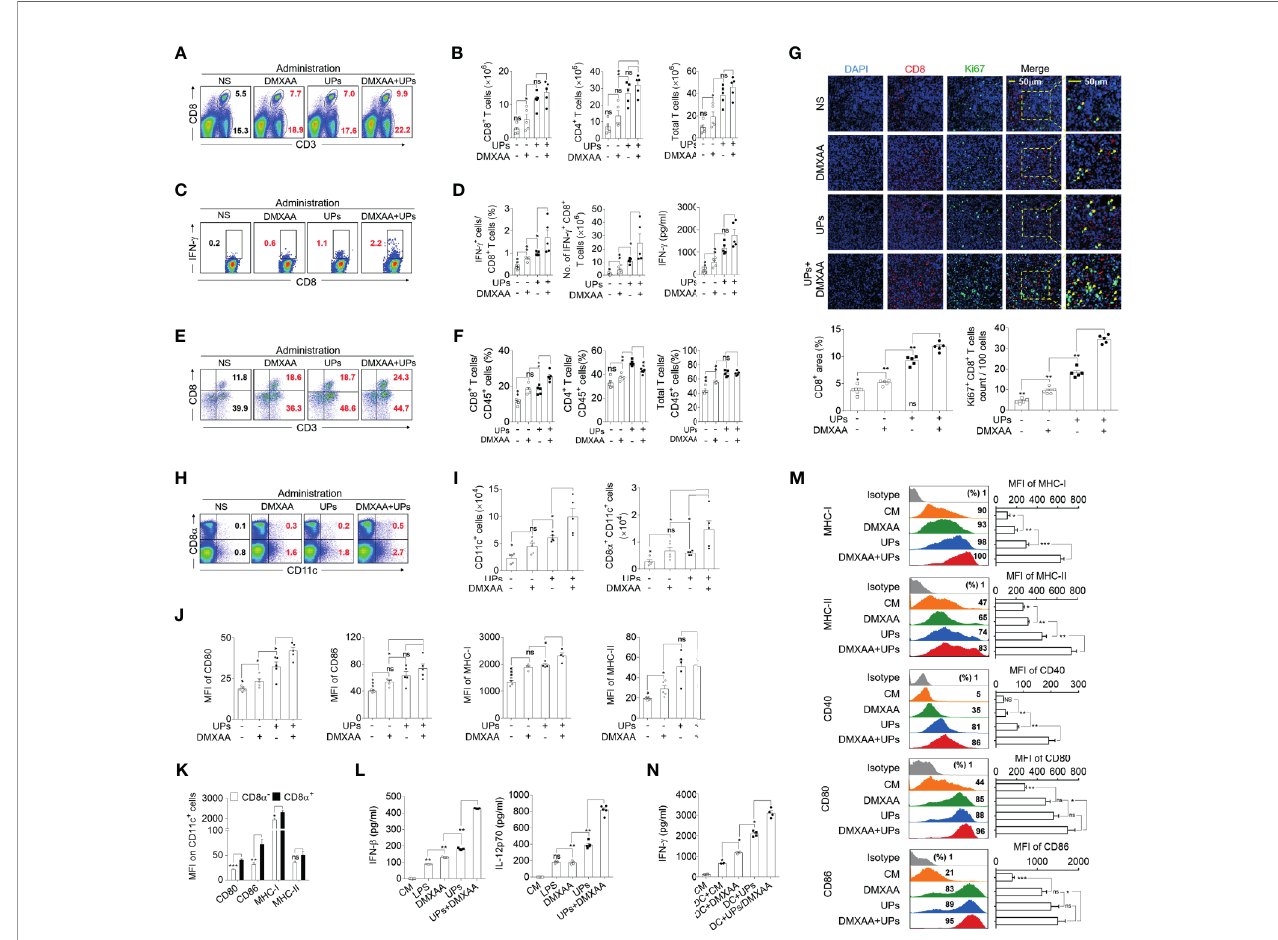
FIGURE 6 | 5,6-Dimethylxanthenone-4-acetic acid (DMXAA) enhanced the anti-tumor effect of ubiquitinated proteins (UPs)-4T1/epirubicin (EPB) nanovaccine through the activation, maturation, and lymph node migration of CD8 a + dendritic cells (DCs). The mice ( n = 5 to 6 per group) were challenged with 5 × 10 5 4T1/EPB cells s.c. on day 0 and received an i.v. injection of EPB on day 5. The mice received a s.c. vaccination of UPs-4T1/EPB nanovaccine alone or combined with DMXAA three times on days 14, 16, and 18. The mice were euthanized on day 21, and their draining lymph nodes (DLNs), spleens, and tumor tissues were collected for the subsequent experiments. (A, B) The representative fl ow cytometric plots of CD8 + T cells, CD4 + T cells, and total T cells in spleens (A) and the absolute numbers were calculated (B) . (C, D) The splenocytes were restimulated with inactivated 4T1/EPB cells for 24 h. Representative fl ow cytometric plots of IFN- g + CD3 + CD8 + T cells (C) . The percentage of IFN- g + CD3 + CD8 + T cells was examined by fl ow cytometry, and the absolute numbers were calculated. The total IFN- g level in the cell supernatant was detected by ELISA (D) . (E, F) Half of each tumor was isolated and processed to a single-cell suspension. Representative fl ow cytometric plots (E) . The percentage (F) of total T lymphocytes (CD45 + CD3 + cells) and T cell subsets (CD45 + CD3 + CD8 + T cells and CD45 + CD3 + CD8 - T cells) was detected using fl ow cytometry. (G) Immuno fl uorescence microscopy images of DAPI (blue), CD8 (red), Ki67 (green), and merged in the remaining half tumor. The CD8 + T cell in fi ltration area was evaluated using Image J Absolute numbers of Ki67 + CD8 + T cells were counted in 100 cells per fi eld from fi ve different fi elds. (H, I) Representative fl ow cytometric plots (H) and absolute numbers (I) of total DCs and CD8 a + dendritic cells (DCs) in DLNs. (J) The mean fl uorescence intensity (MFI) values of CD80, CD86, and MHC class I and II on CD8 a + DCs from different groups. (K) The MFI values of CD80, CD86, and MHC class I and II on CD8 a - DCs and CD8 a + DCs from UPs-4T1/EPB plus the DMXAA group. (L, M) Bone marrow-derived DCs (BMDCs) were cultured with DMXAA, UPs (4T1/EPB), and DMXAA plus UPs (4T1/EPB) after 24h. IFN- b (top) and IL-12p70 (bottom) were measured in the culture supernatants by ELISA (L) . Expression analysis of MHC class I and II, CD40, CD80, and CD86 on BMDCs by fl ow cytometry (M) . (N) Splenocytes from UPs-4T1/EPB vaccinated mice were co-cultured with BMDCs from different groups in (M) for 12 h, and the IFN- g secretion in the supernatant was examined by ELISA. Splenocytes alone and splenocytes cocultured with untreated BMDCs served as the controls. P -values were determined by Mann – Whitney U -test. The results are representative of three independent experiments, and data were expressed as means ± SEM (* p < 0.05; ** p < 0.01; *** p < 0.001; ns, not signi fi cant); P < 0.05 was considered signi fi cant. All data are presented as mean ±